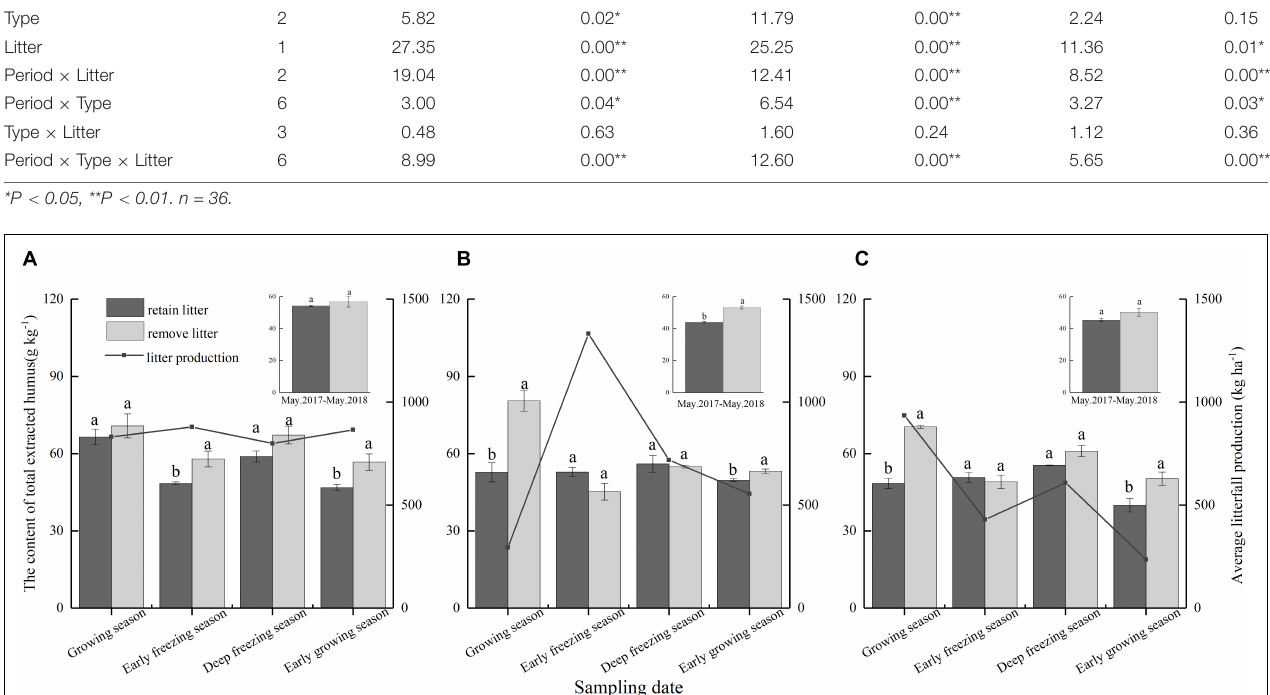
TABLE 2 | Repeated measures ANOVA results for the effects of incubation period, forest type, litter, and their interactions on soil total extracted humus, humic acid, and fulvic acid. Factors df Total extracted humus HA FA F sig. F sig. F sig. 3 68 . 36 0 . 00 ** 37 . 80